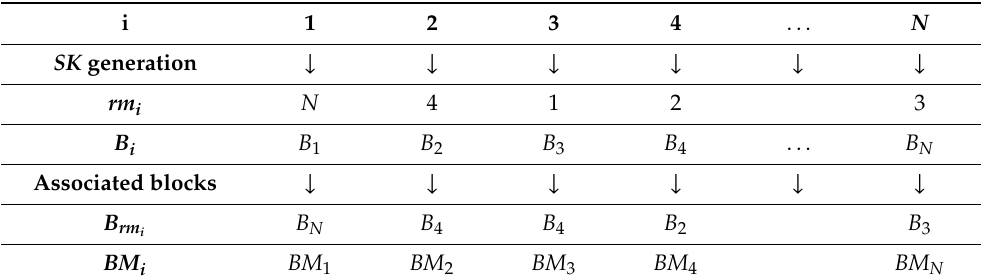
Figure 1. Flowchart of watermark generation and embedding process based on “block-wise detection” (The size of a block is 4 × 4). Table 1. Relationship between the original block and the mapping block.